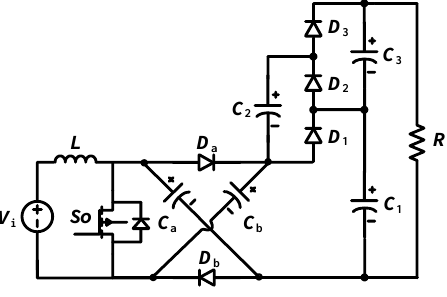
Figure 3. Proposed SC boost DC-DC.